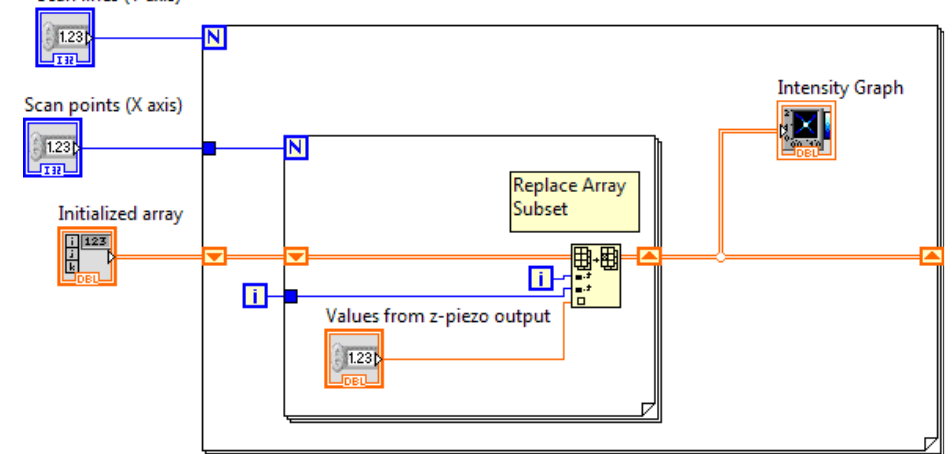
Figure 7. A simplified schematic of the scanning sequence in the LabVIEW block diagram. The nested “For Loops” plays an important role in performing the scanning sequence efficiently. The inner loop controls positions in the X axis and the outer loop controls voltage steps along the Y axis. The “Replace Array Subset” is used here to update the values of pixels in real-time during the scanning process. The “Intensity Graph” is in the outer loop so that the 2D plot is updated after one line scan. If it is in the inner loop instead, the 2D plot will be updated pixel by pixel.